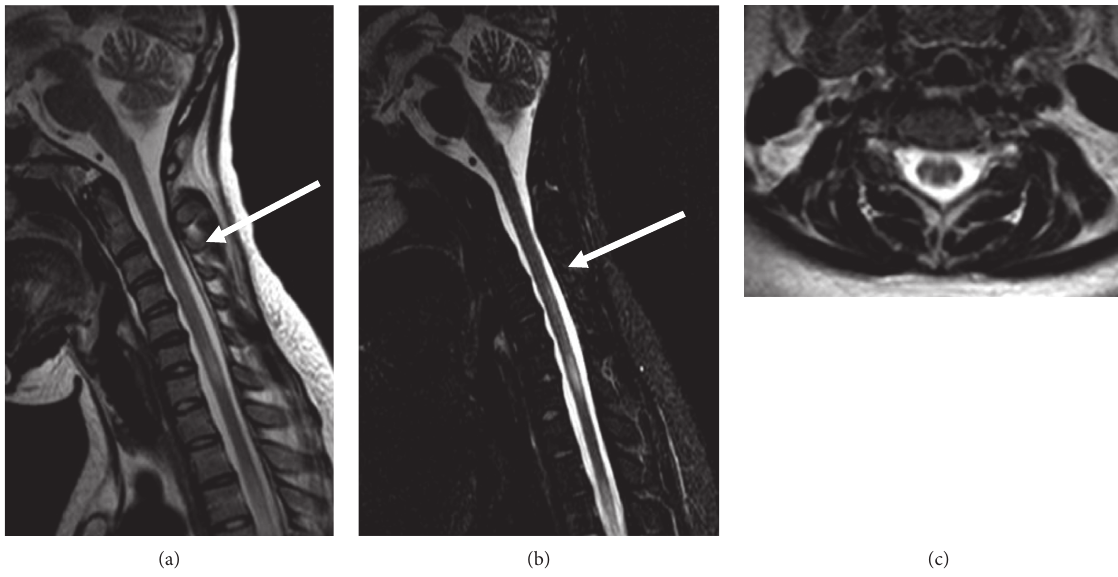
Figure 2: Follow-up MRI of the cervical and thoracic spine two months after treatment. (a) Sagittal STIR and (b) T2-weighted MRI images show interval improvement of the previously seen abnormal spinal cord signal intensity. (c) Axial T2-weighted image at C4 level demonstrates interval improvement of the previously seen abnormal signal